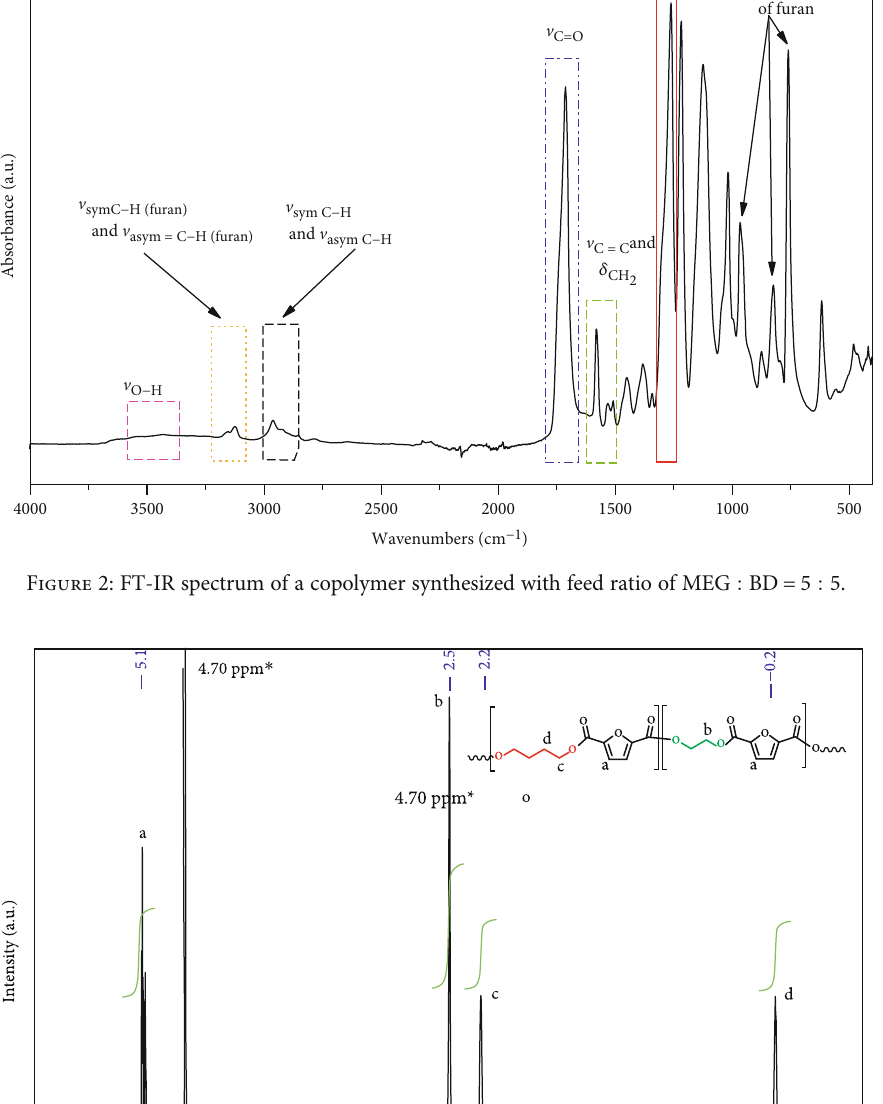
O and TFA-d1 were 2